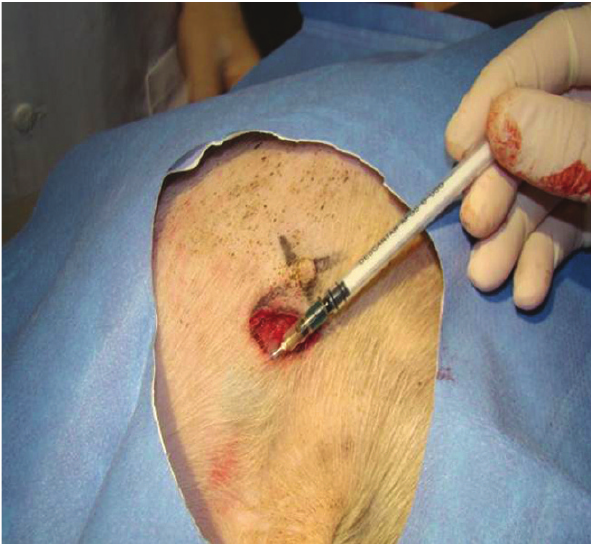
Figure 3 - Injection of blue dye (bleu patente´ V Guerbet 2.5%) just above the midpoint of the arcuate top edge of the incision in the subdermal region.